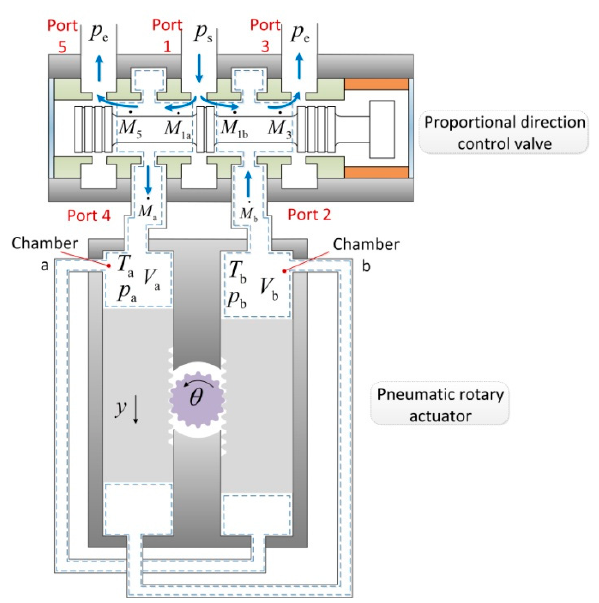
Figure 3. Schematic diagram of the valve-controlled actuator system.